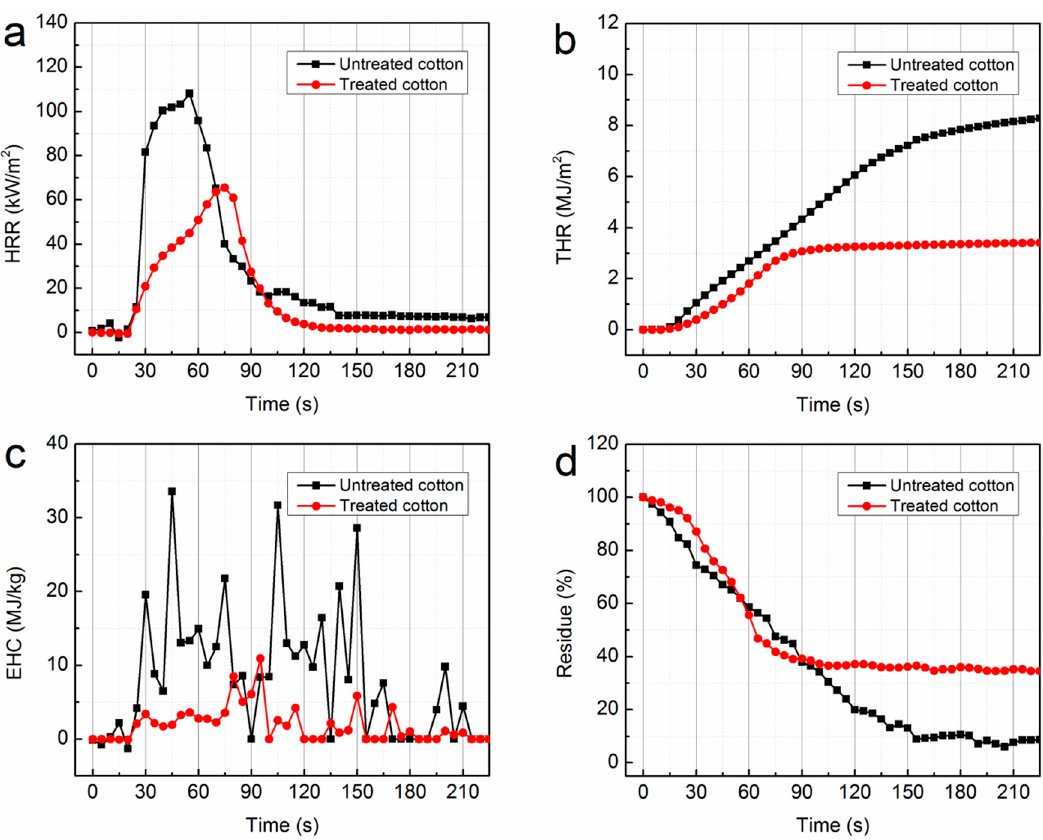
Figure 4. Heat release rate (HRR) ( a ), total heat release (THR) ( b ), effective heat of combustion (EHC) ( c ), and residue ( d ) curves of untreated and treated cotton fabrics.